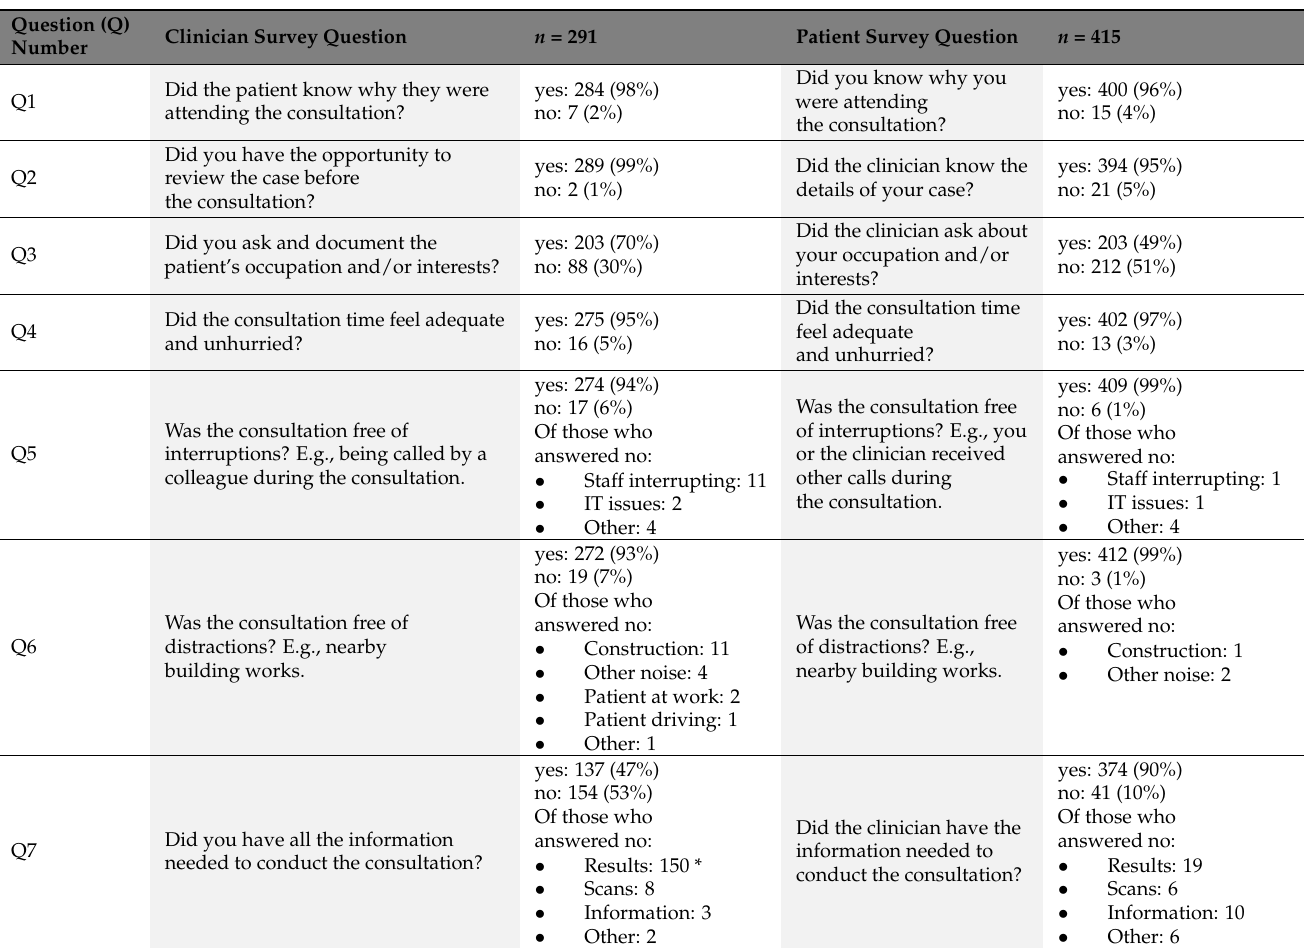
Table 2. Clinician and patient survey